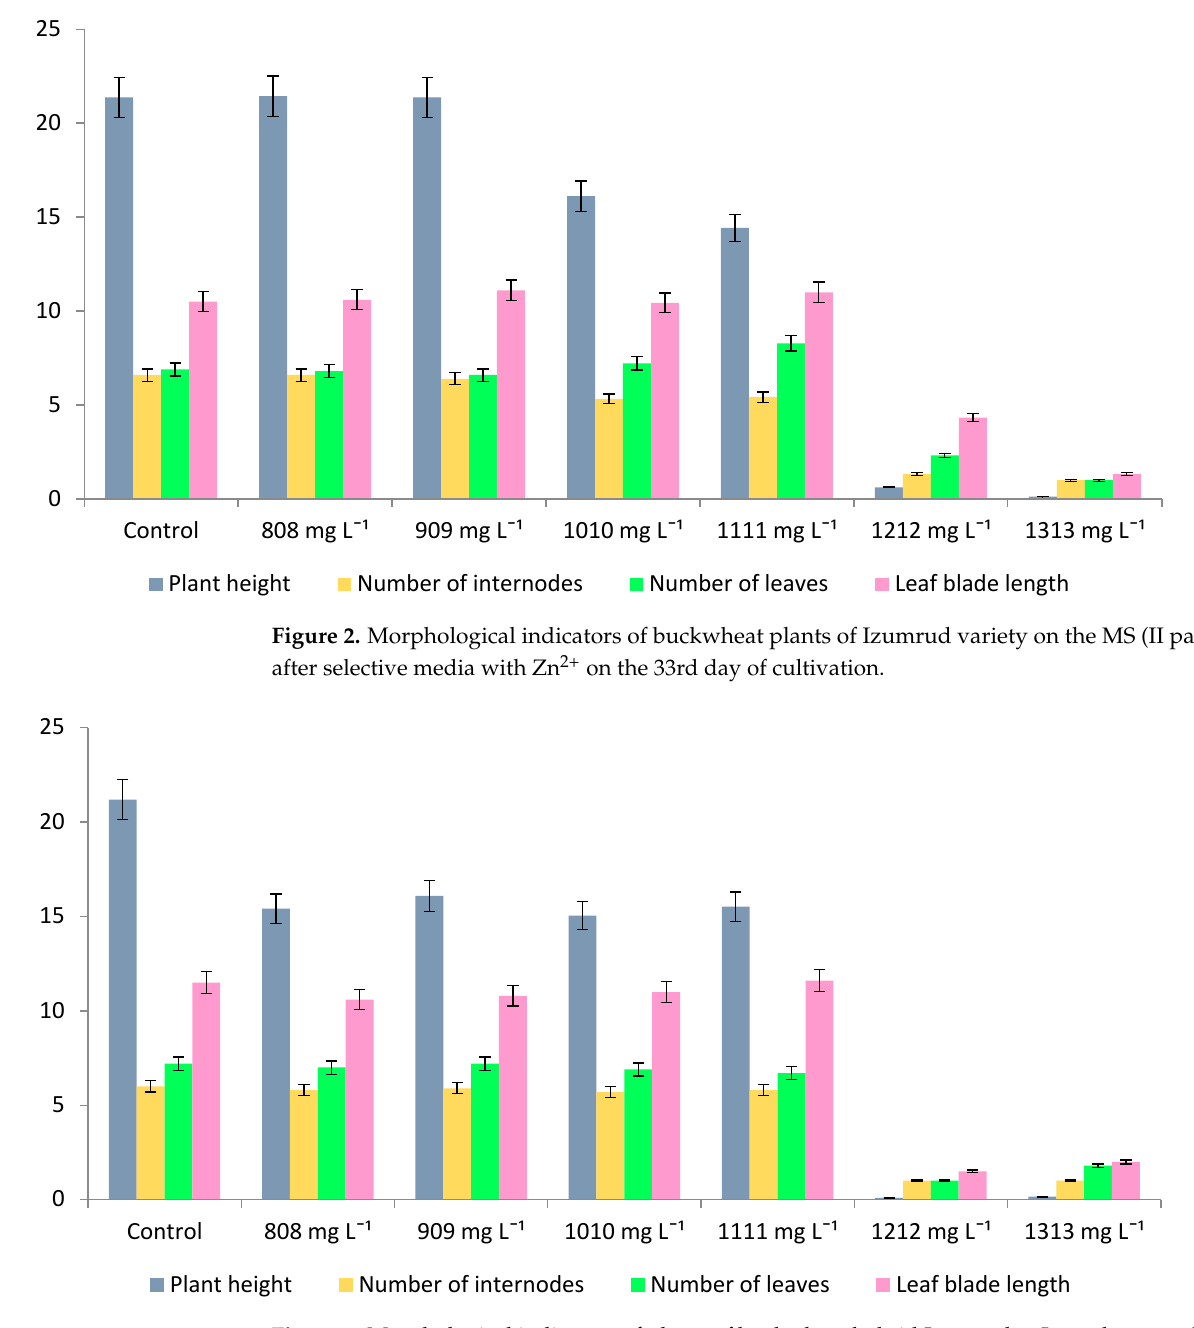
Figure 3. Morphological indicators of plants of buckwheat hybrid Izumrud × Inzerskaya on the MS (II passage) after selective media with Zn 2+ on the 33rd day of cultivation.